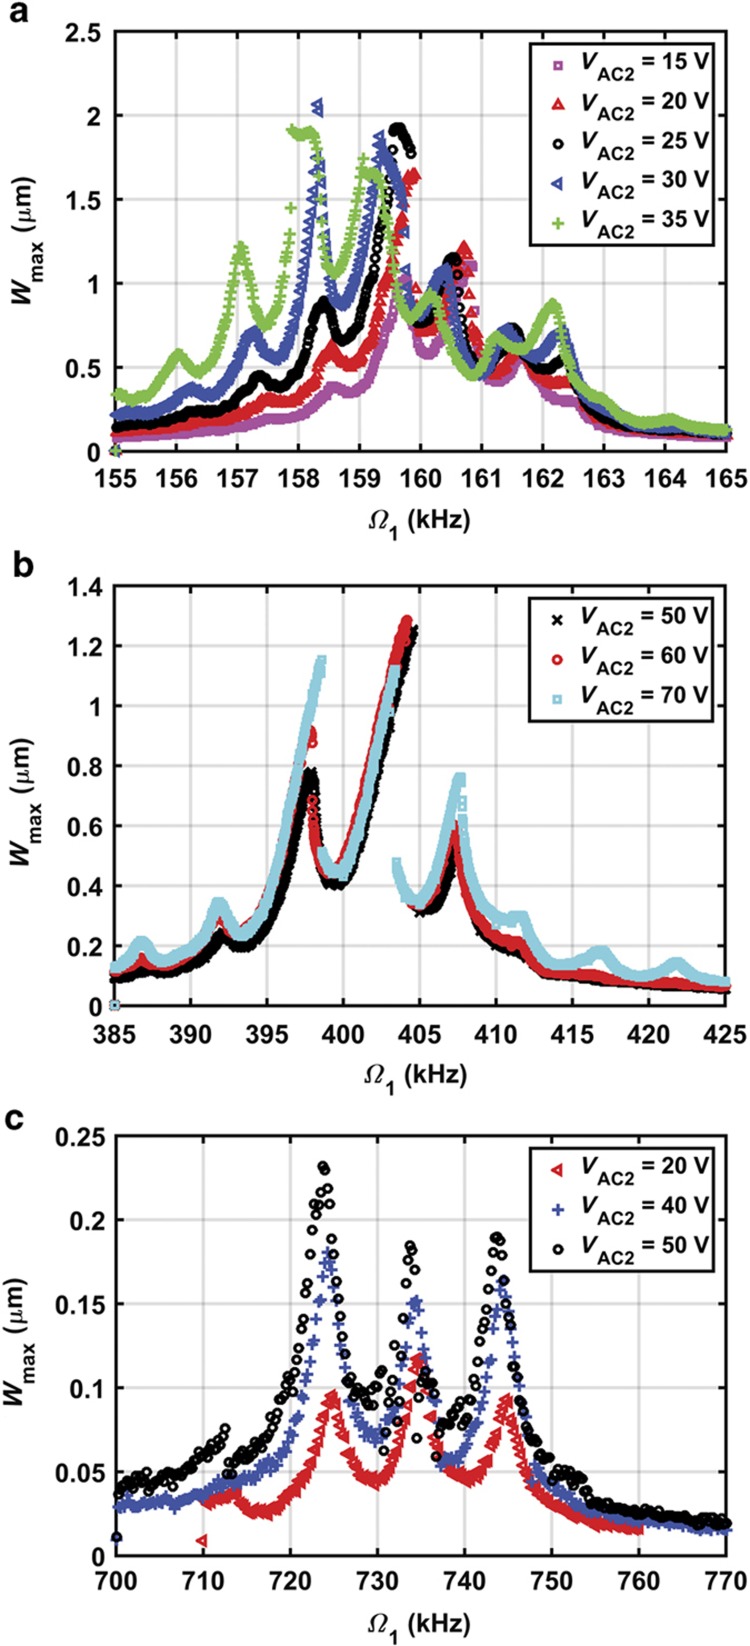
Frequency response curves for different values of VAC2. (a) VDC=15 V, VAC1=5 V, and Ω2=1 kHz near the first mode; (b) VDC=15 V, VAC1=20 V, and Ω2=5 kHz near the second mode; and (c) VDC=20 V, VAC1=40 V, and Ω2=10 kHz near the third mode.